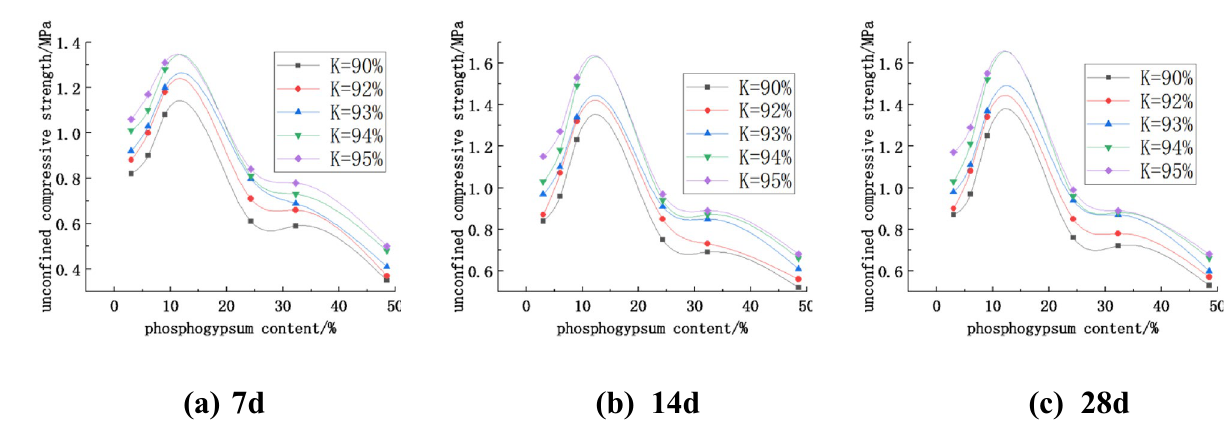
Fig. 1 Relationship between unconfined compressive strength of mixture and phosphogypsum content at different ages (3% cement)